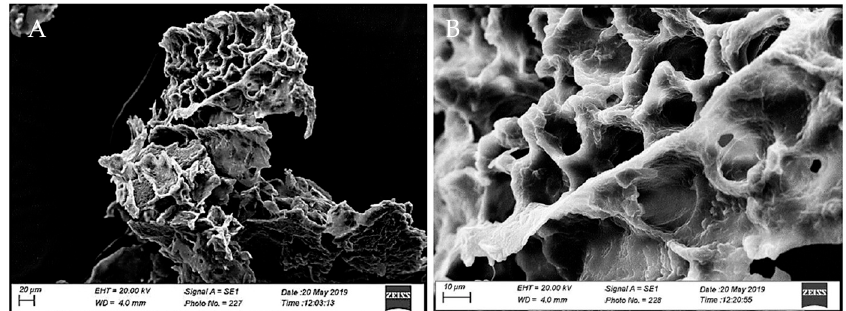
Figure 4. SEM images of surface morphology and internal structure of Sponge-C-MTR. ( A ) magnitude bar = 20 µ m; ( B ) magnitude bar = 10 µ m.